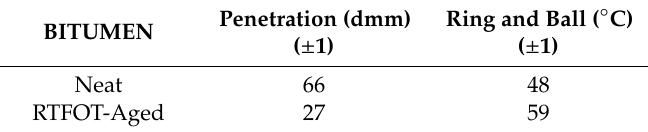
Table 1. Penetration grade and ring and ball test results.